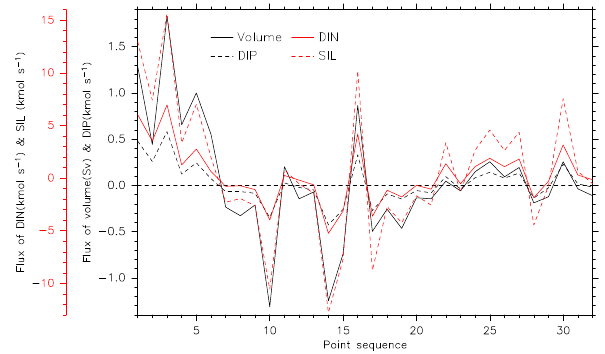
Fig.11 Fig. 11. Spatial distribution along the 200-m isobath of the annual average onshore flux of volume (Sv) and nutrients (kmols − 1 ). The value at each point is the integrated flux between two points denoted by dots along the 200-m isobath in Fig. 1. The positive direction is toward the ECS shelf. The black solid line denotes volume, the red solid line DIN, the black dashed line DIP, and the red dashed line